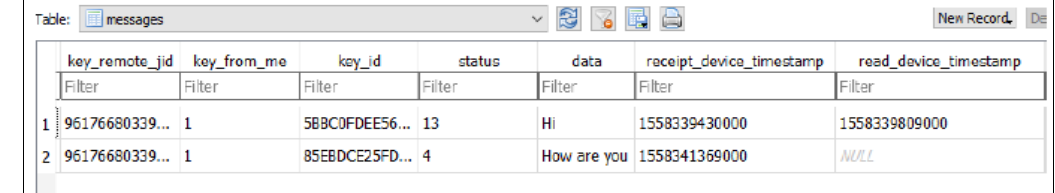
Figure 19. Message state: message is transmitted to server(1) and message is not transmitted to server(2)